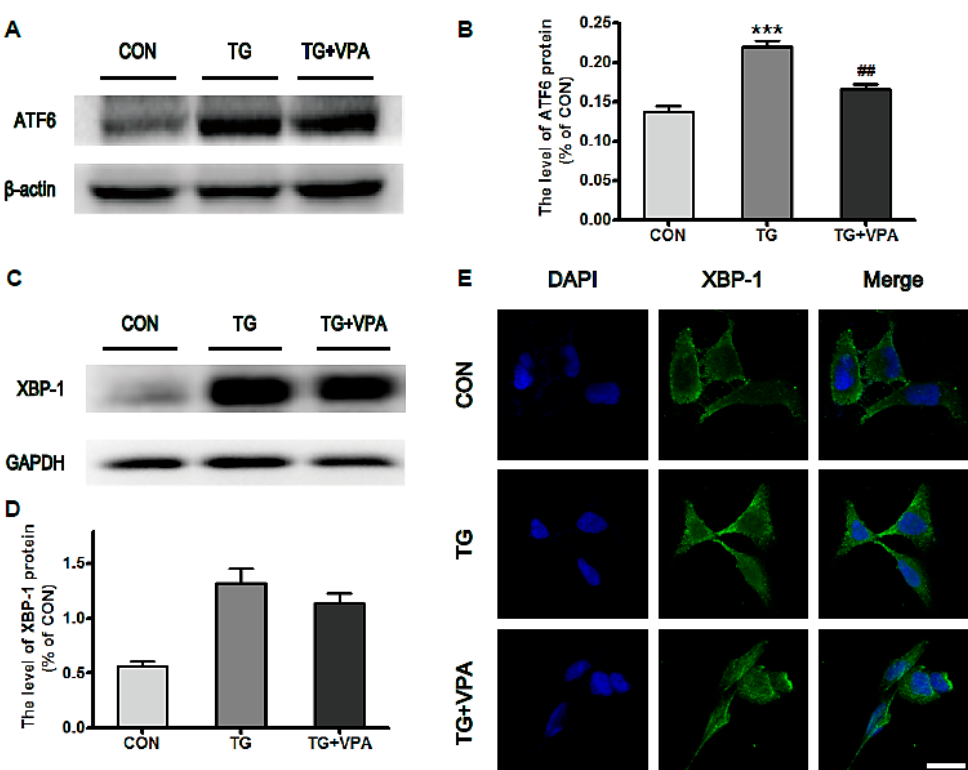
Figure 3. VPA attenuates TG induced ER stress in SH-SY5Y cells. ( A , C ) The protein level of ATF6 and XBP-1 in the control, TG, and TG and VPA groups; ( B , D ) The optical density analysis of ATF6 and XBP-1 protein. ## p < 0.01 versus the TG group; *** p < 0.001 versus the control group; ( E ) Immunofluorescence of XBP-1 (green); the nuclear (blue) was labelled with DAPI. Magnification was 40 × . Data are the mean values ± SEM, n = 3.